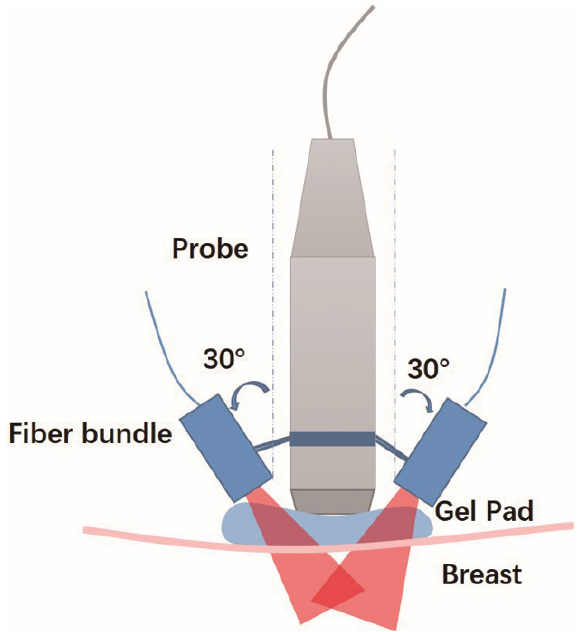
Fig. 1. Schematic diagram of dual-modality imaging